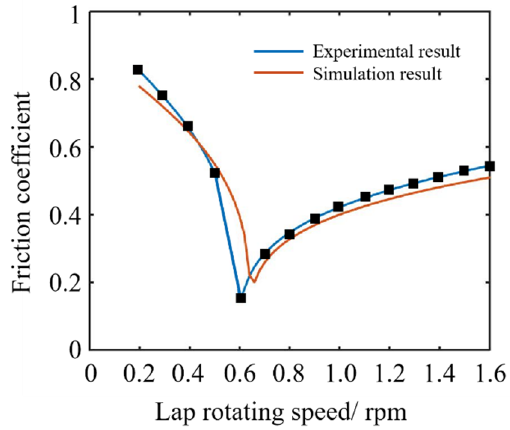
Figure 11. Experimental and calculated results of friction coefficient.